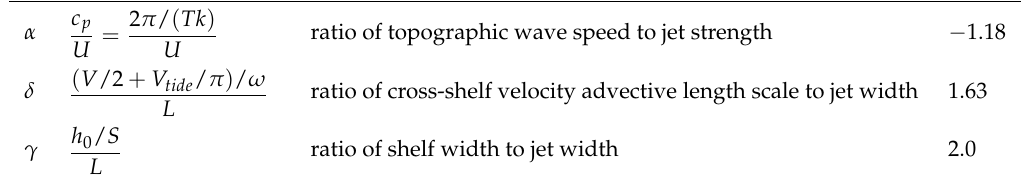
Table 2. Non-dimensional parameters, their definition, physical meaning, and base case values. c p α ratio of topographic wave speed to jet strength − 1.18 U ratio of cross-shelf velocity advective length scale to jet width ratio of shelf width to jet